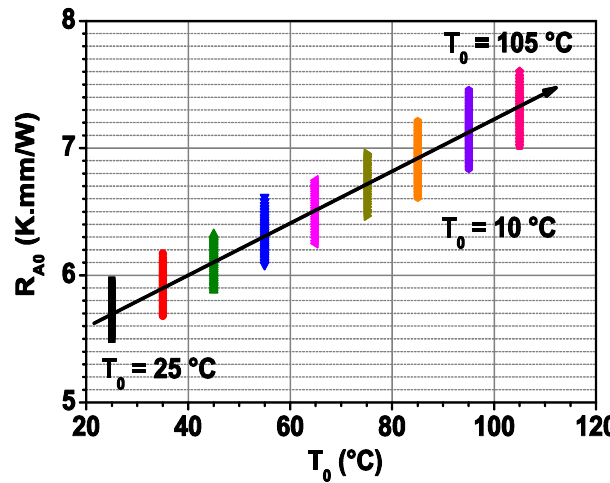
Figure 6. Temperature dependence of normalized thermal resistance R A0.